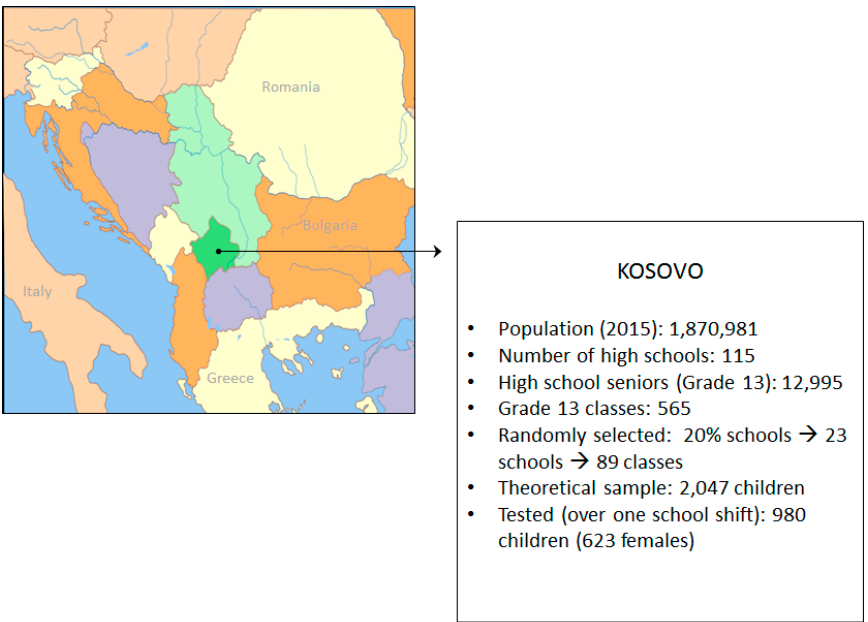
Figure 1. Geographical location of Kosovo and sampling procedure.